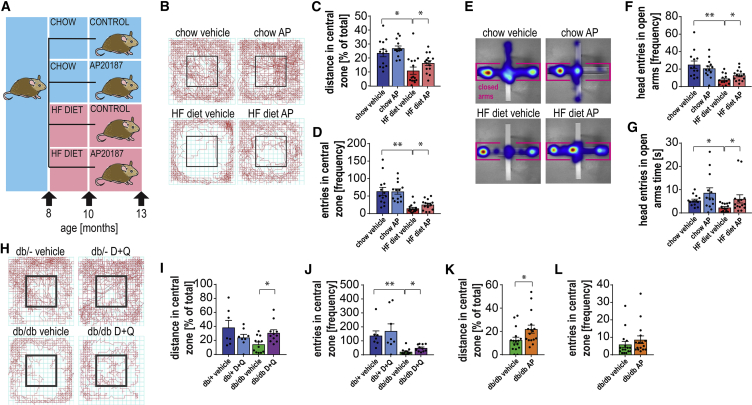
Pharmacogenetic and Pharmacologic Clearance of Senescent Cells from Obese Mice Alleviates Obesity-Related Behavioral Changes(A) Eight-month-old C57Bl/6(INK-ATTAC) male mice were split into four groups and assigned to chow (n = 24) or high fat (HF, n = 30) diets and treated at 10 months of age with vehicle (n = 12 for chow and n = 15 for HF) or AP20187 (n = 12 for chow and n = 15 for HF) until 13 months of age.(B–D) (B) Open-field (OF) testing: representative movement traces (red lines) of lean and obese INK-ATTAC mice treated with/without AP20187 (AP) indicates that anxiety-like behavior of HFD mice can be alleviated by AP treatment as measured by (C) the normalized distance traveled in the central area of the OF box (U = 36, p = 0.0037; U = 64, p = 0.0453) and (D) increased frequency of entries into the central area. Alleviation of anxiety-like behavior of HFD mice was also observed in the EPM test (U = 10.5, p < 0.0001; U = 64.5, p = 0.0463).(E) Representative heatmap images of the time mice spent in open and closed sections of the EPM. Parameters were registered by EthoVision software.(F and G) (F) Frequency of head pokes into the open arms (U = 17.5, p < 0.0001; t(27) = 2.1; p = 0.0452) and the (G) time mice spent with their heads in the open area were significantly reduced with HFD and increased with AP (U = 26, p = 0.001; U = 59.5, p = 0.0472).(H) Representative movement traces (red lines) of db/db and heterozygous control mice with or without treatment with senolytic cocktail, dasatinib + quercetin (D+Q) in the OF test during a 30-min trial.(I and J) Data indicate an improvement in the anxiety-like behavior of db/db mice upon D+Q treatment determined by OF test parameters: (I) normalized distance traveled in the middle area (t(7.259) = 2.269, p = 0.0562; t(21) = 3.001, p = 0.0068) and (J) frequency of entries into the middle area of the OF box (U = 1, p < 0.0001; U = 24.5, p = 0.009).(K and L) In the OF test, INK-ATTAC;db/db mice (K) displayed a significant difference in the distance traveled in the central area after treatment with AP20187 compared to vehicle (U = 61; p = 0.0106), but (L) the number of entries into the central area was not significantly increased after treatment with AP (U = 85.5; p = 0.1096).Data are from n = 12–15 mice per group for (A)–(G); n = 8–12 mice per group for (H)–(J); n = 5–9 mice per group for (K)–(L). Mean ± SEM plotted. ∗p ≤ 0.05 and ∗∗p ≤ 0.001.